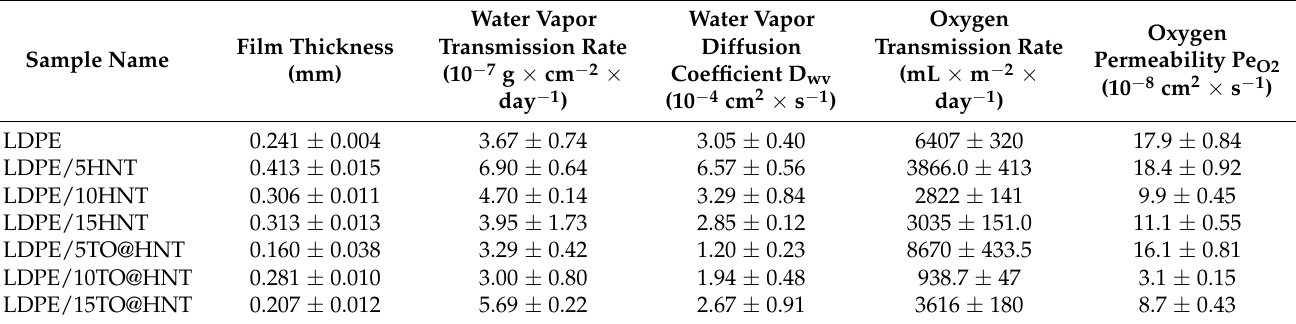
Film thickness, WVTR, D wv , OTR, and Pe O2 values of all LDPE/xHNT